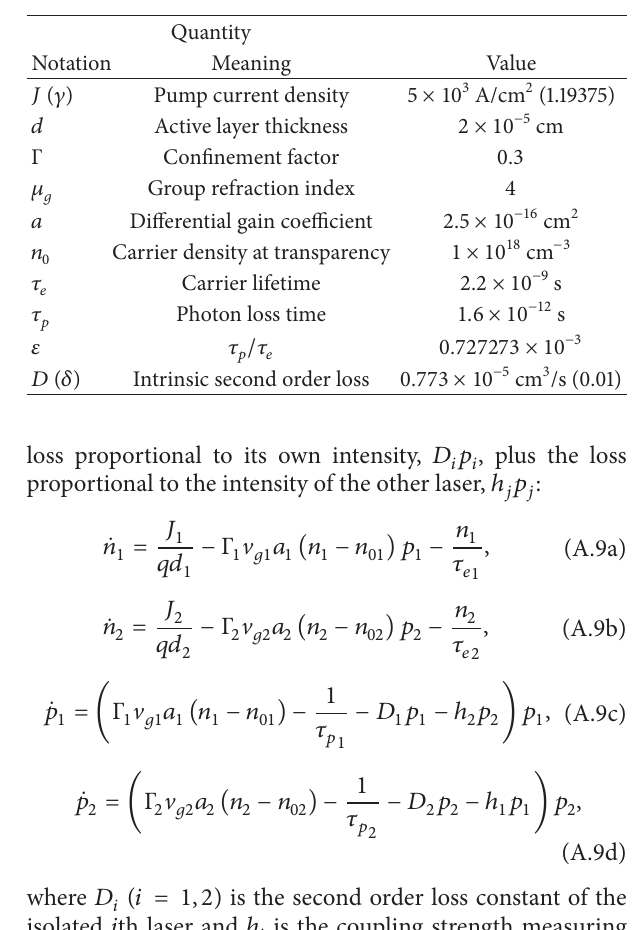
Table 2: Laser parameters used for numerical simulations. The val- ues in parentheses stand for associated nondimensional